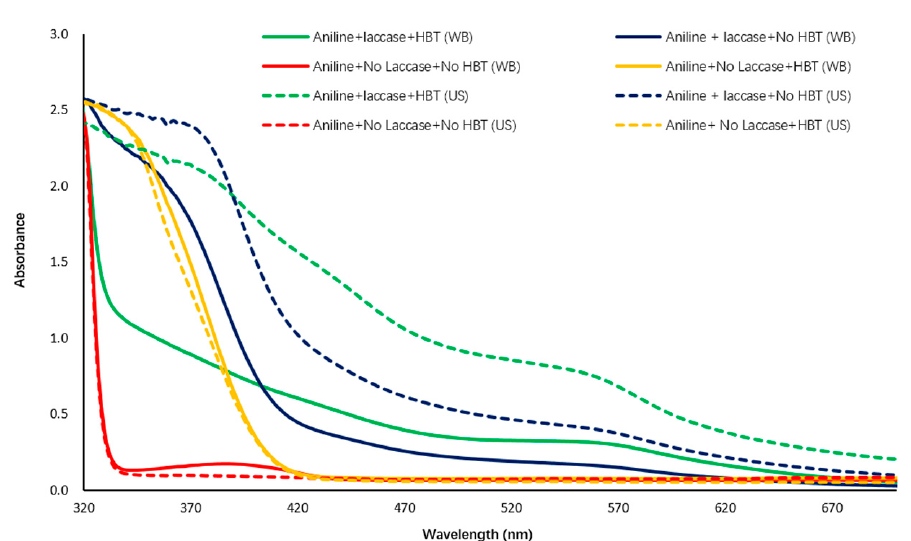
Figure 2. UV-Vis-NIR (Ultraviolet–visible-near-infrared) spectra of polyaniline solutions. Experiment conditions: 50 mM aniline incubated with 25 U/mL laccase at 25 °C using: (a) HBT (10 mM) in a water bath for 24 h; (b) without HBT in a water bath for 24 h; (c) HBT (10 mM) in an ultrasonic bath for 2 h; (d) without HBT in an ultrasonic bath for 2 h.